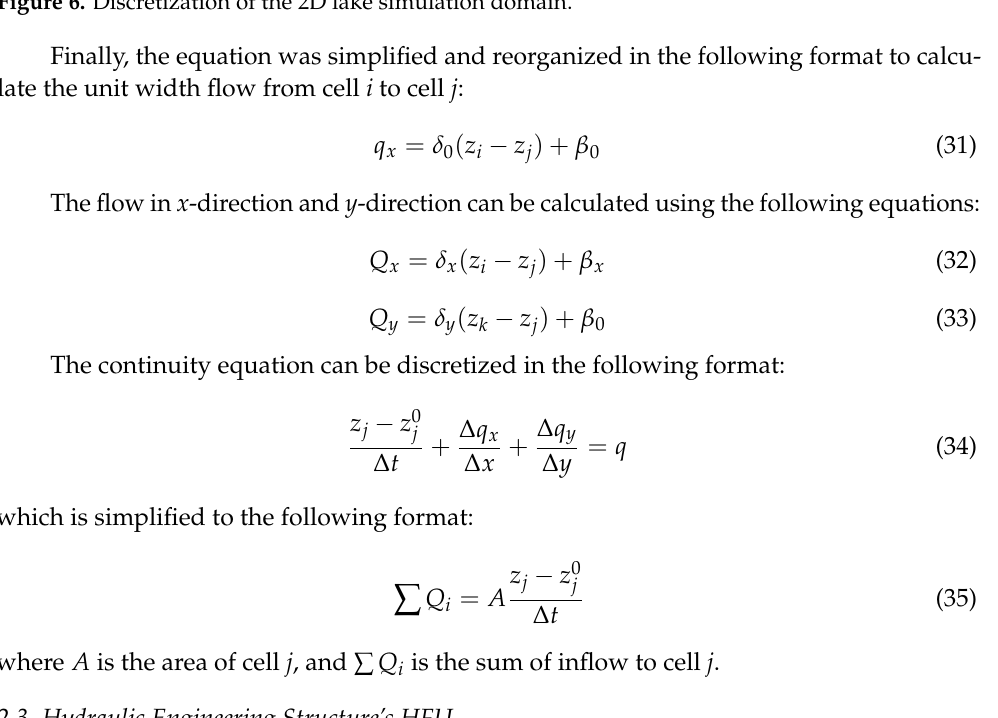
Figure 6. Discretization of the 2D lake simulation domain.